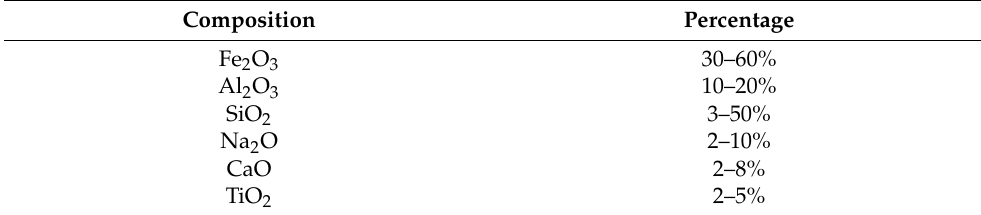
Table 1. Elemental composition of red